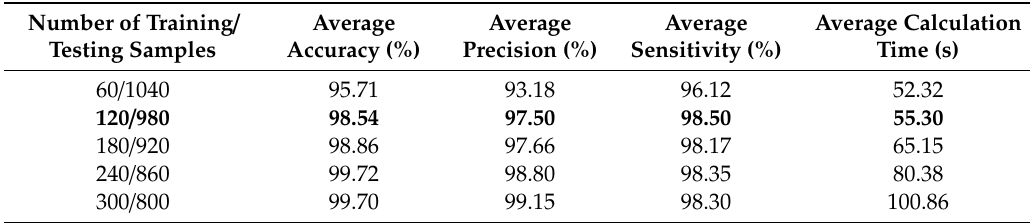
Table 5. The e ff ects of the sample proportion on the performance of the proposed